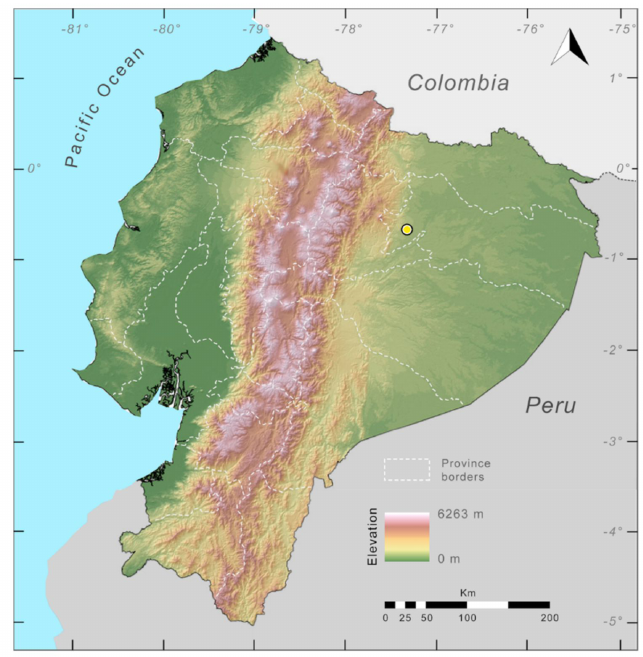
Figure 164. Distribution of Nymphargus laurae in Ecuador (yellow